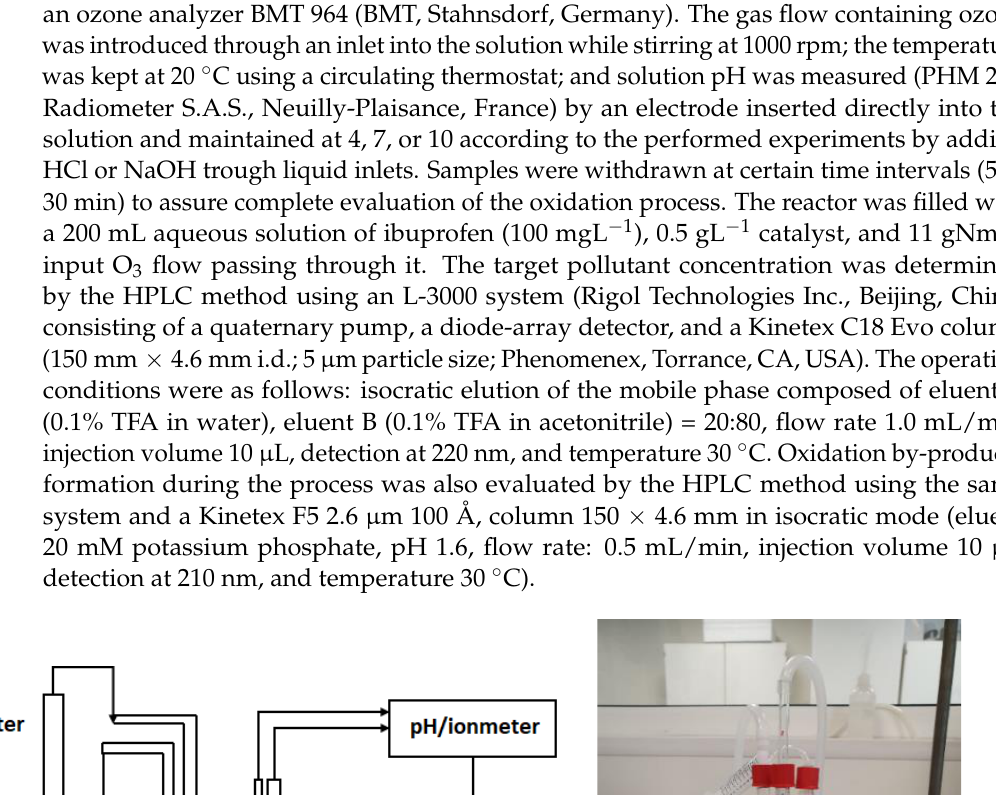
Figure 2. SEM image of PANI with magnitude of 8 kx ( left ) and 30 kx ( right ). Raman spectroscopy has demonstrated to be a useful analytical tool to investigate conducting polymers and carbon – based materials. Raman spectra of PANI and corre- sponding carbonized PANI 900 are presented in Figure 3.